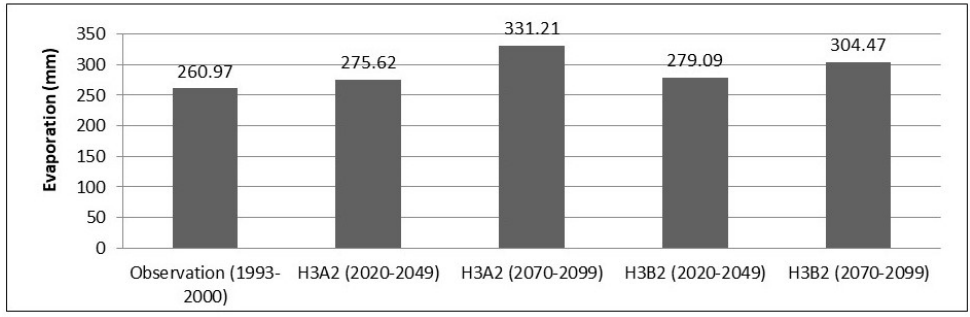
Figure 9. Mean annual evaporation time series in observation period and A2 and B2 scenarios in the near and far future.